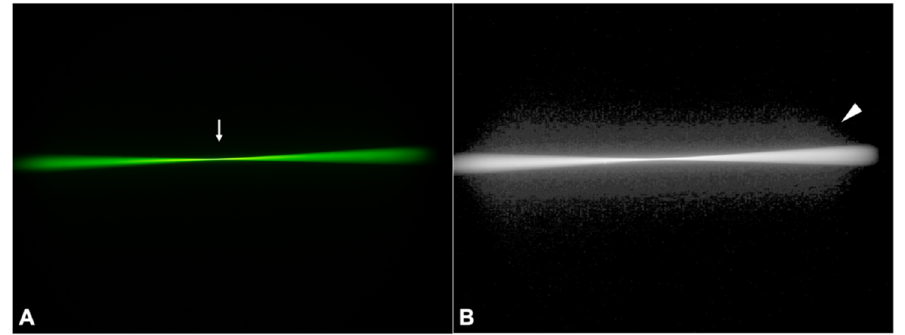
Figure 3. Ray propagation ( A ) and light scattering ( B ) of the control IOL. The arrow indicates the focal point of the studied IOL, while the arrowhead points to the scatter light made visible as background haze when the ray propagation image is converted to a log image.